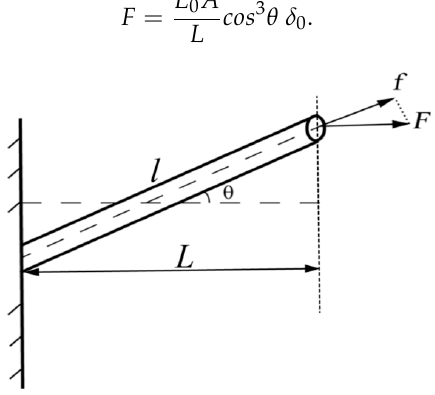
Figure 3. Single fiber stretched-schematic diagram.